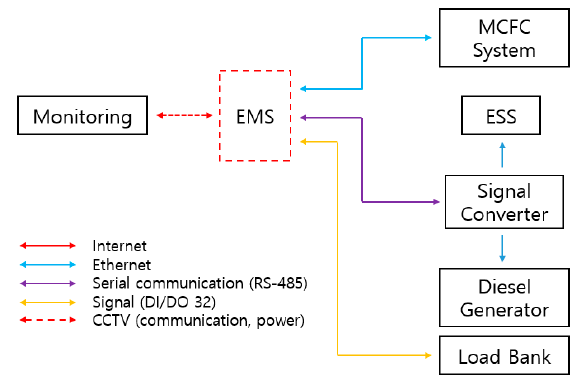
Figure 8. Integrated power control system configuration.